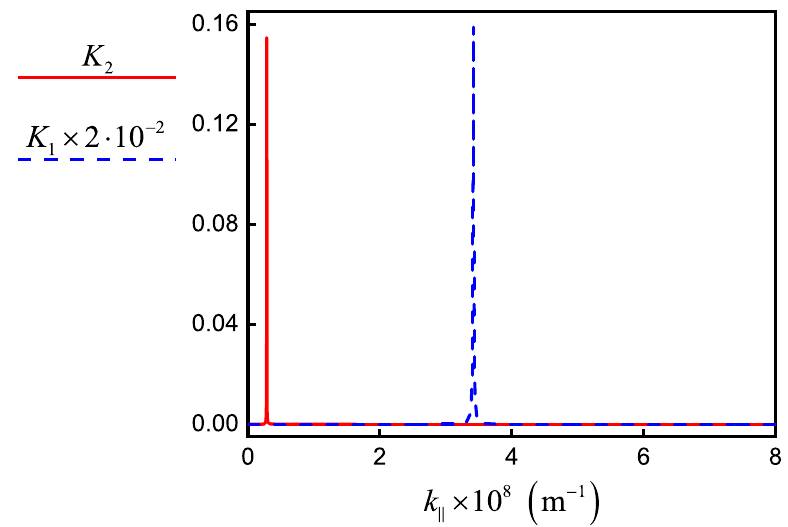
Figure 8. The dependence of integrands K 1 for wavelength λ 1 = 2.56 µm (dashed blue line) and K 2 for wavelength λ 2 = 8.04 µm (solid red line) as a function of the in-plane wave vector k (cid:107) for emitting InAs/ZnS NW that is placed at 10 nm from the graphene (parameters in Table 1).